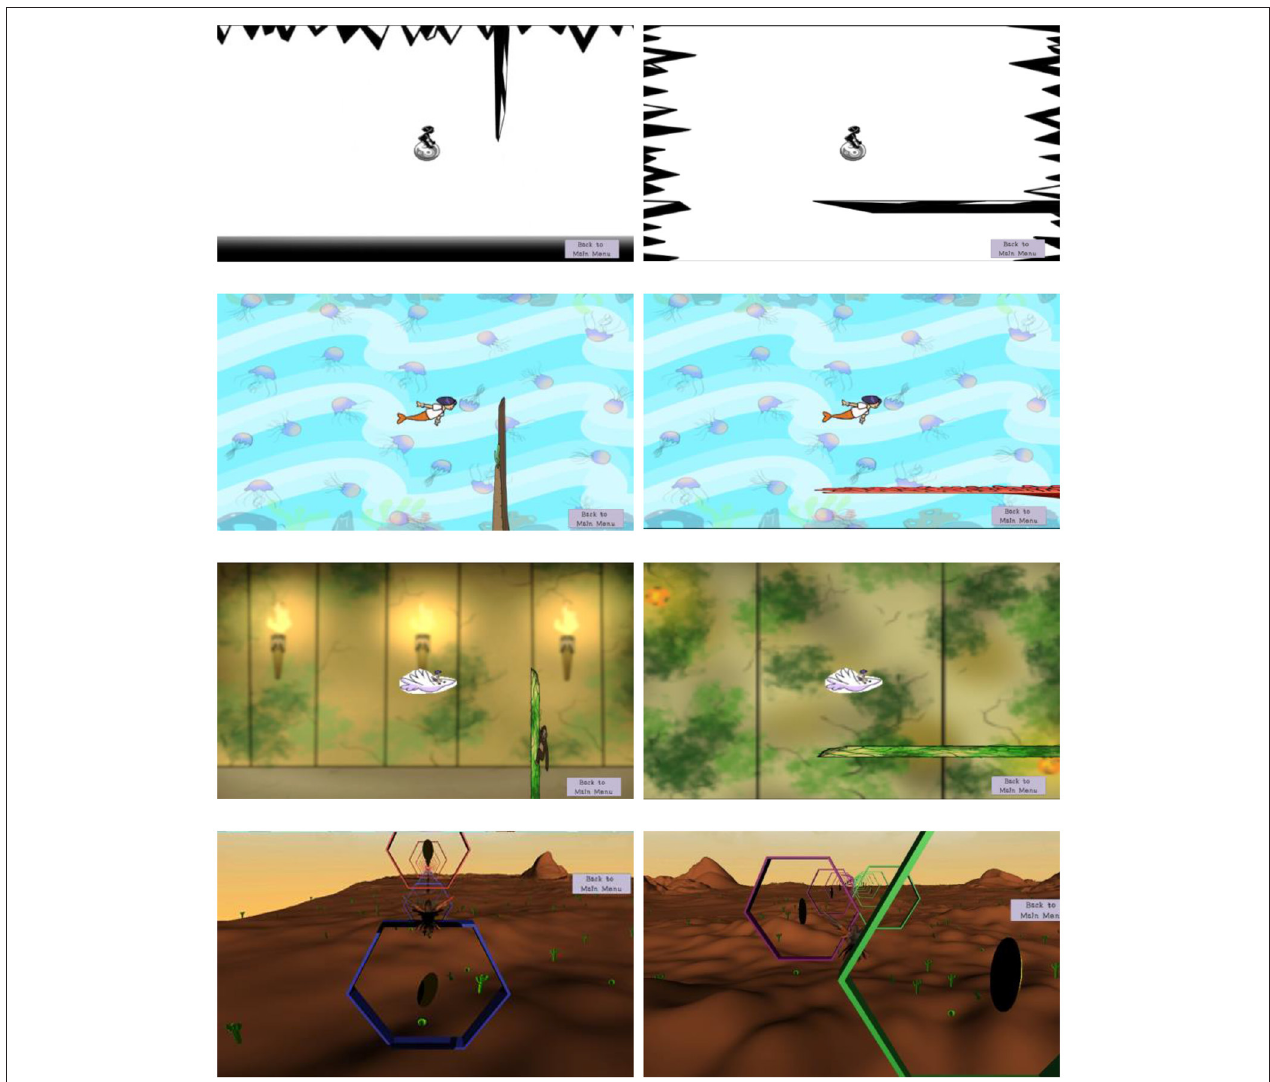
FIGURE 1 | Four different levels of exercise for VOR in the pitch and yaw direction (left and right column respectively). The various levels of visual stimuli are tailored to the severity of symptoms due to vestibular dysfunction. Patients progress from simple backgrounds (top row), to a complex static background (2 nd row), a complex dynamic background (3 rd row–torches flicker), to a 3D background with texture and the character and background moving (bottom row). Note that although the background was static for the first two rows, the obstacles and character still moved over the